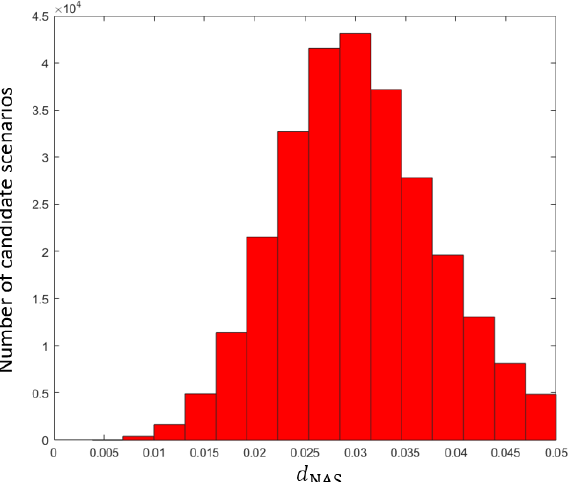
Figure 17. The distribution of distances between candidate scenarios and their nearest adverse sce-